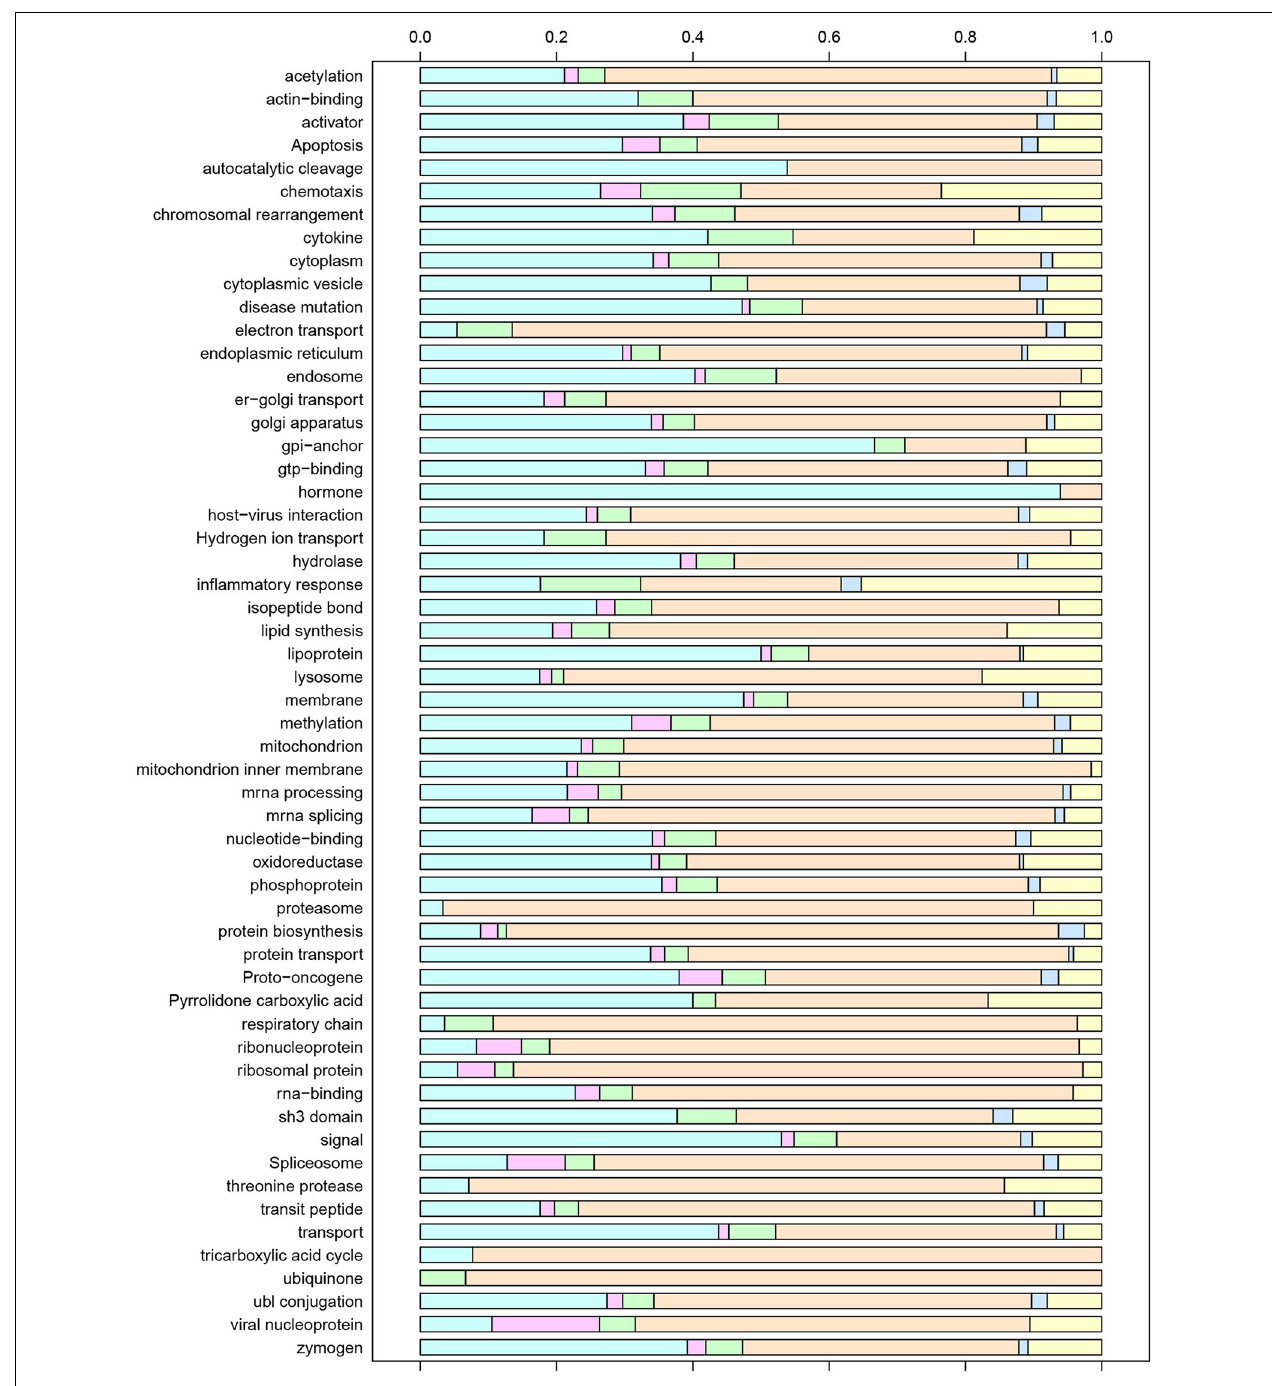
FIGURE 5 | Enriched SP-PIR keywords for the set of unique gene IDs associated with post-exposure time T and/or final severity score S at the α = 0 . 05 significance level. For each keyword, the